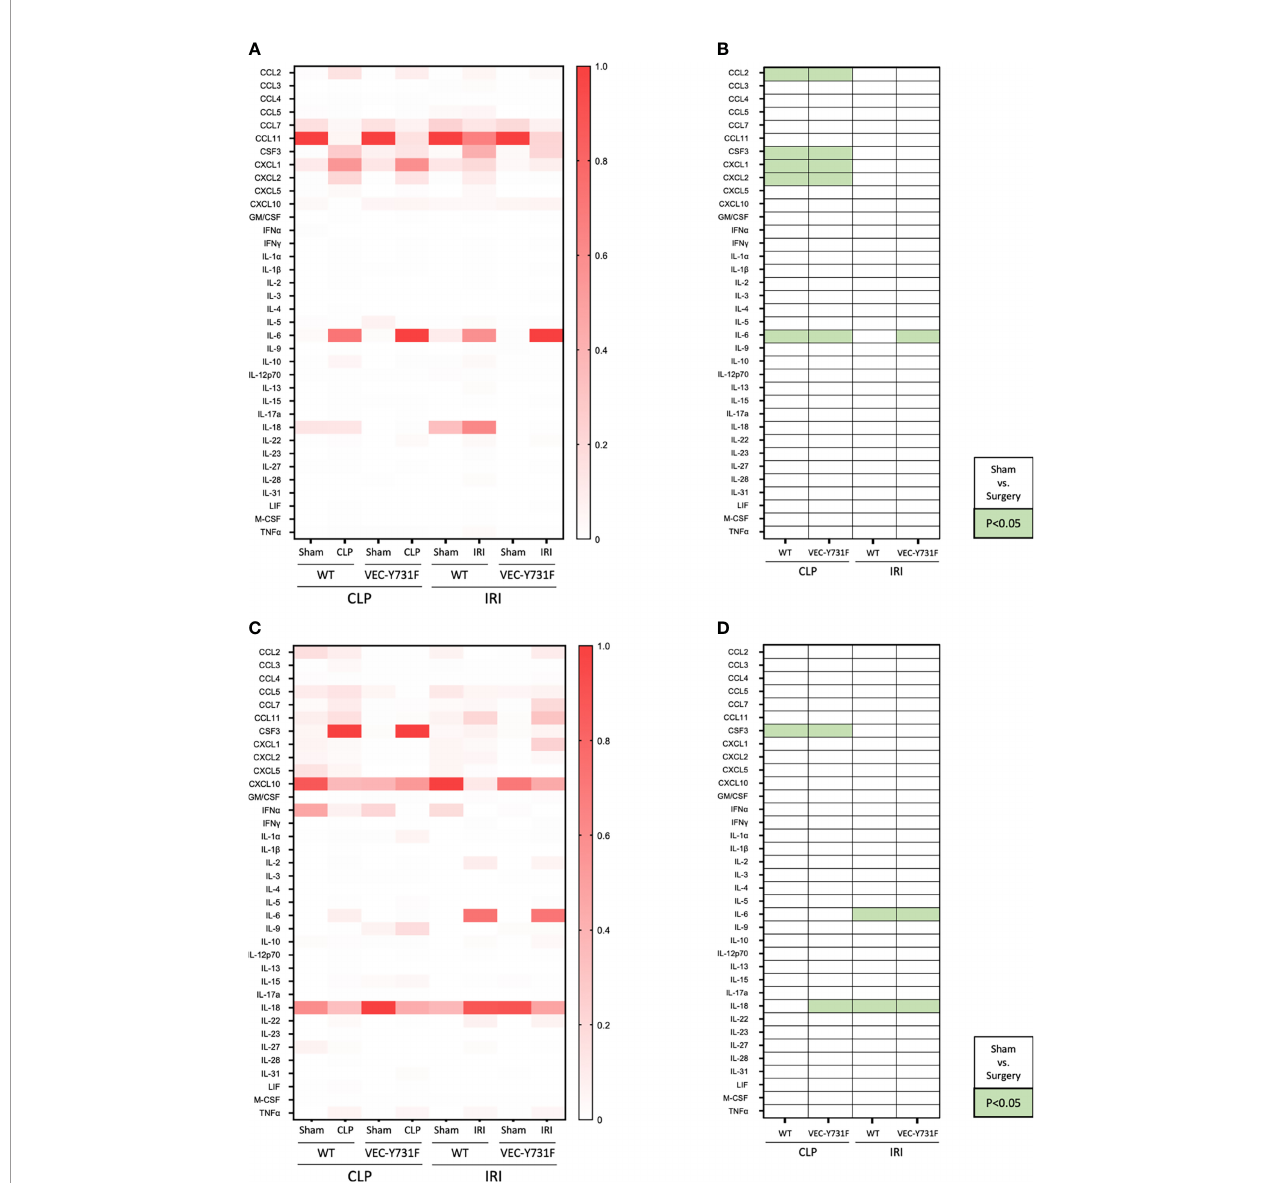
FIGURE 4 | CLP- and IRI-induced AKI is associated with different patterns of in fl ammatory mediators in plasma and urine. AKI in WT and VEC-Y731F mice was induced either by CLP or IRI. 24 hours after AKI-induction the concentrations of in fl ammatory mediators in the plasma (A, B) and the urine (C, D) were analyzed by multiplex analysis including a panel of 36 different analytes (n=5-12). Visualization was performed by normalizing each subcolumn separately and de fi ning the largest value in each subcolumn as 100% using Prism built-in analysis. Heat map data are presented as fractions for plasma (A) and urine (C) samples. Signi fi cant differences (p < 0.05) between sham and surgery groups are displayed in green for plasma (B) and urine (D) samples (n =